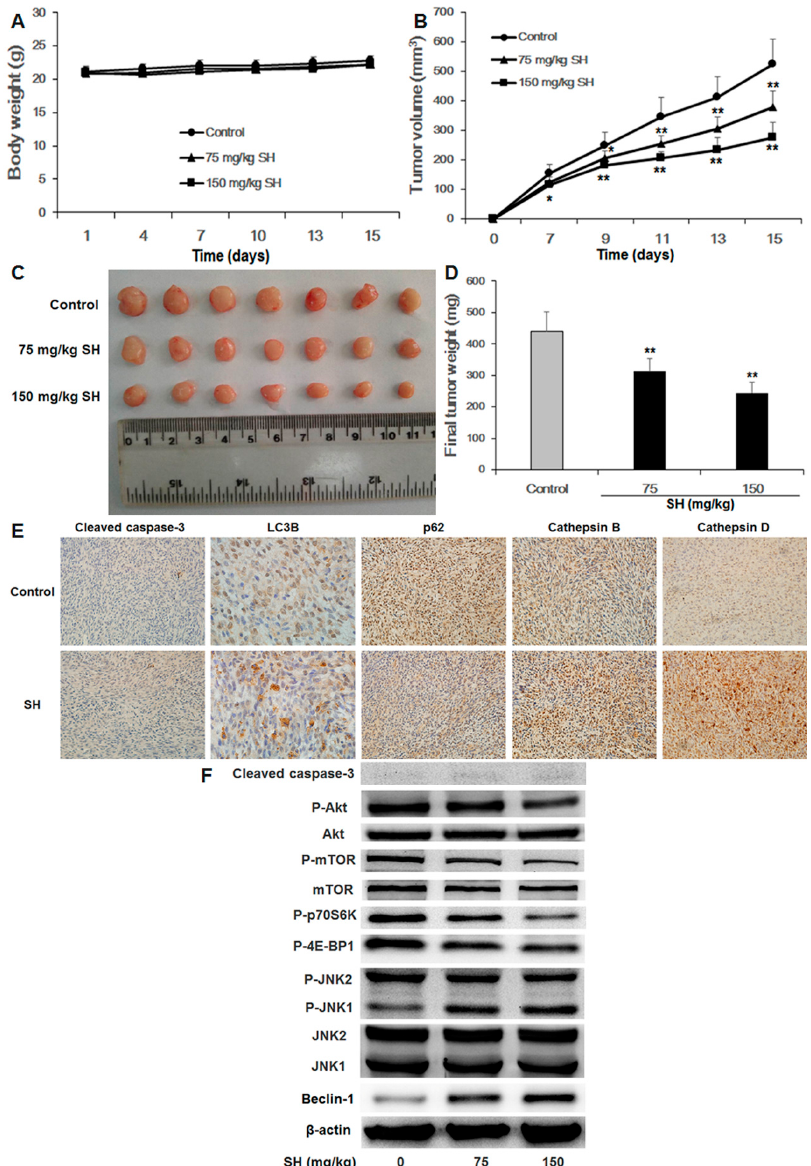
Figure 7. SH suppresses the growth of human glioblastoma tumors in vivo. ( A ) Body weight and ( B ) tumor volume were recorded every 2–3 days; ( C ) Images of tumors are shown; ( D ) Tumor weight was assessed on the fifteenth day after U87 cell implantation. ( E ) Immunohistochemical staining of cleaved caspase-3, LC3B, p62, cathepsin B and cathepsin D in tumor sections treated with physiological saline or SH (150 mg/kg). The panels are representative overview images taken at 400 × magnification, with the exception of the immunohistochemical staining of LC3B (1000 × magnification); ( F ) The indicated proteins from transplanted mouse U87 human glioblastoma tissues were examined via Western blotting. β -actin was used as the loading control. Data are represented as the mean ± SEM of seven mice in each group. * p < 0.05, ** p < 0.01, SH-treated group compared with the control group not treated with SH.